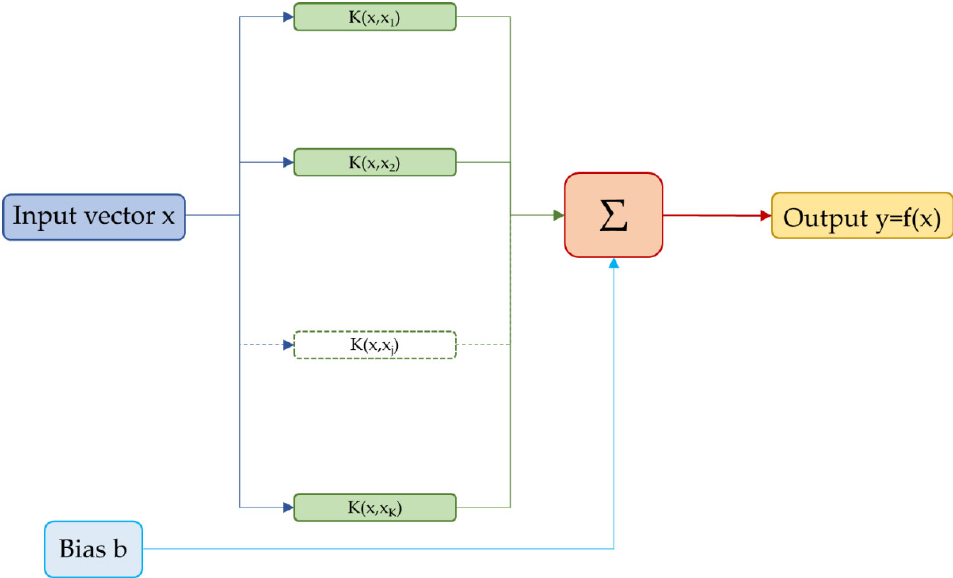
Figure 3. Typical architecture of the support vector regression algorithm.